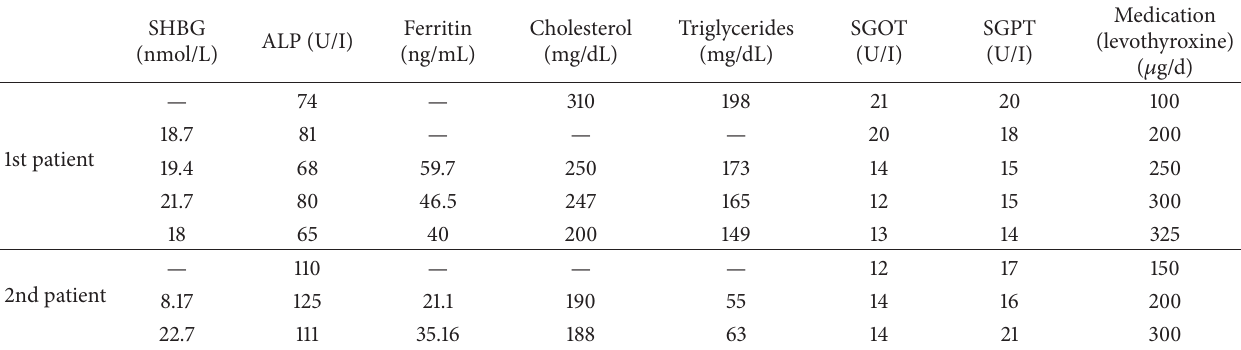
Table 3: Markers of metabolism on increasing doses of levothyroxine, in both